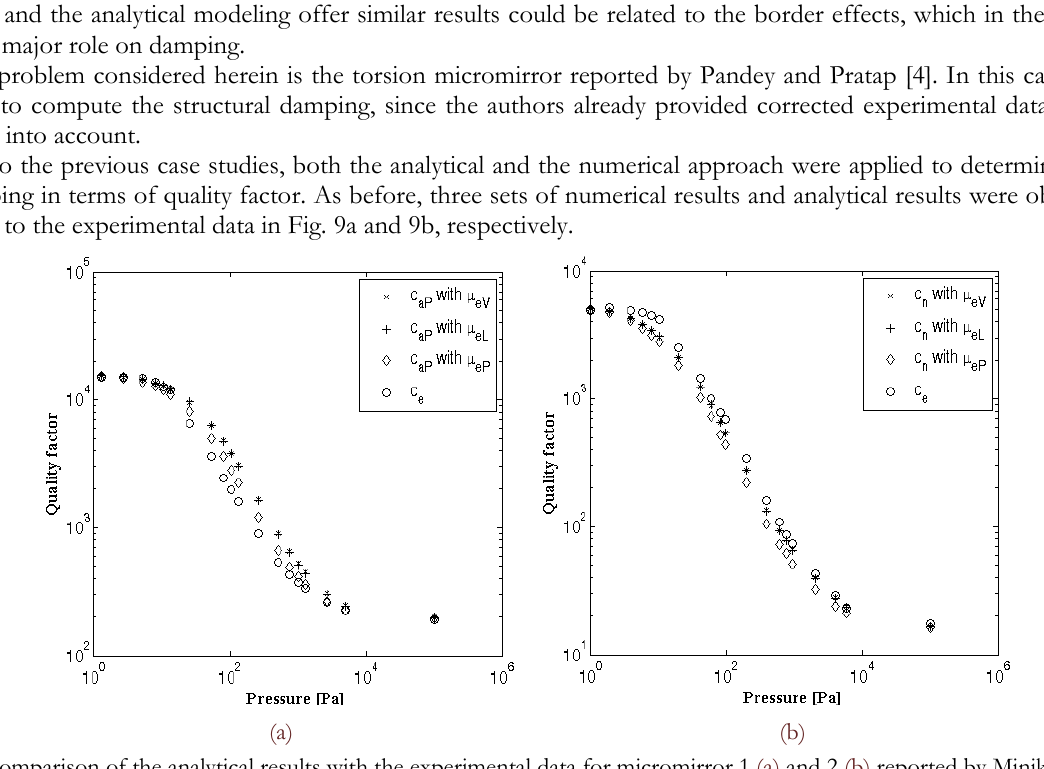
Figure 8: Comparison of the analytical results with the experimental data for micromirror 1 (a) and 2 (b) reported by Minikes et al